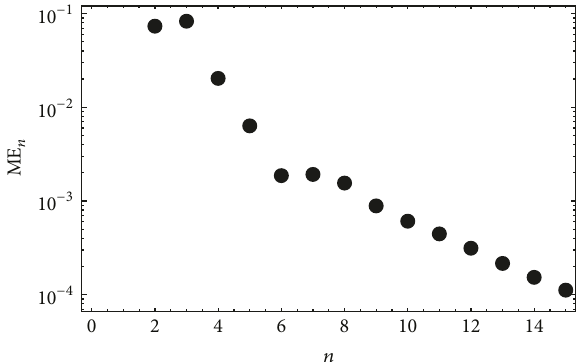
Figure 8: Logarithmic plots of the maximal errors ME 𝑛 versus 𝑛 for 𝑛 = 2 through 15 obtained by the Duan-Rach modified ADM.